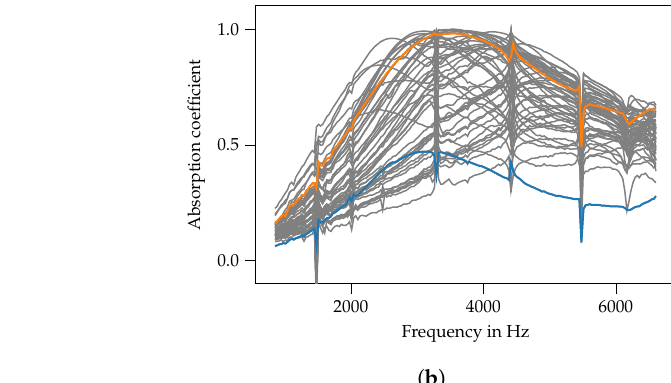
Figure 2. Measurement results of all 50 test specimen. The specimen with the highest mean absorption coefficient is marked in orange. The specimen with the lowest mean absorption coefficient is marked in blue. ( a ) Flow resistivity measurement results of all specimen. The flow resistivity was measured using the alternating flow method [36]. ( b ) Absorption coefficient measurement results of all spec- imen. The absorption coefficient was measured in an impedance tube using the two-microphone technique